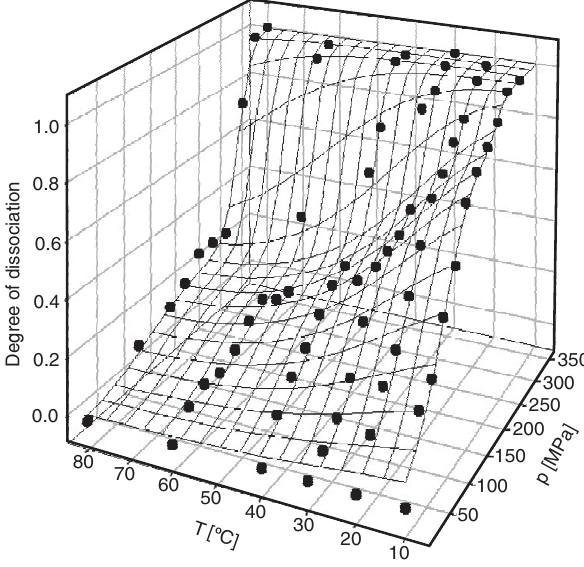
Figure 2. Temperature-pressure profile of the dissociated fraction of casein micelles (pH 7.3) and simultaneous fit according to the model of Equations